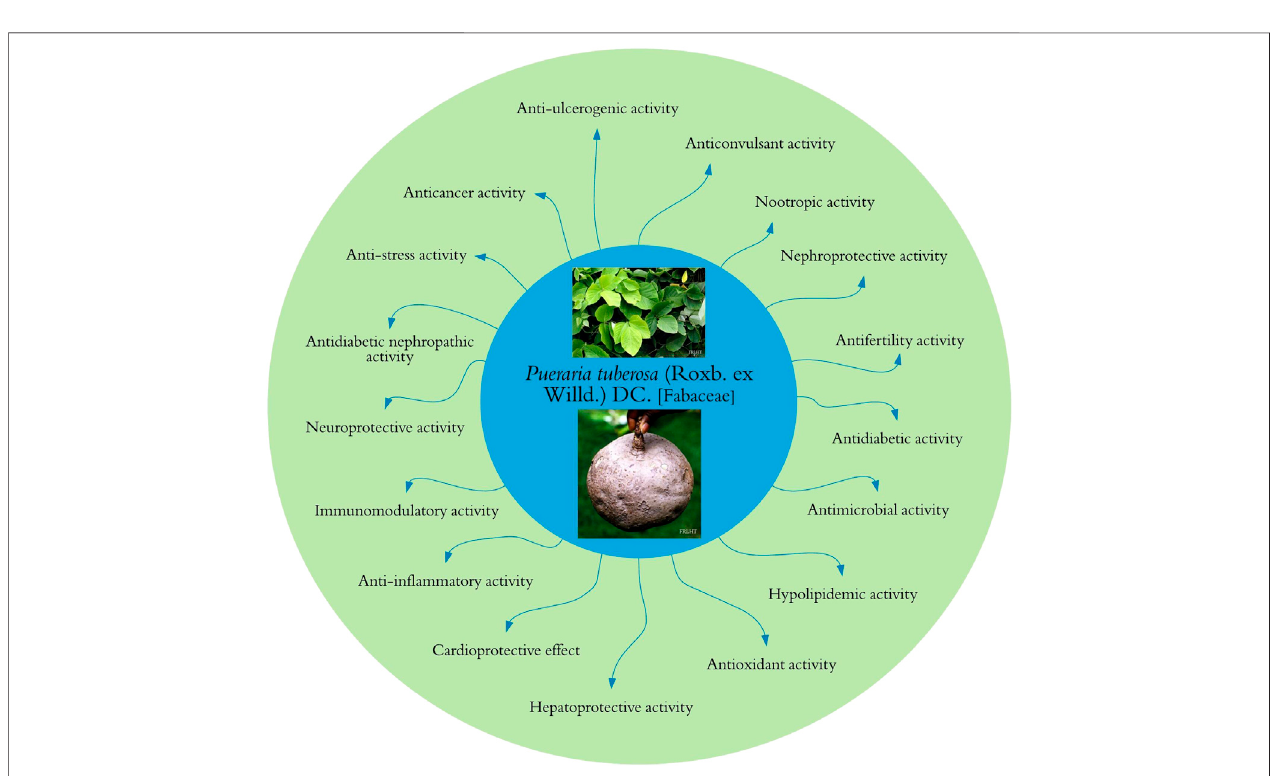
FIGURE 5 | Pharmacological activities of Pueraria tuberosa